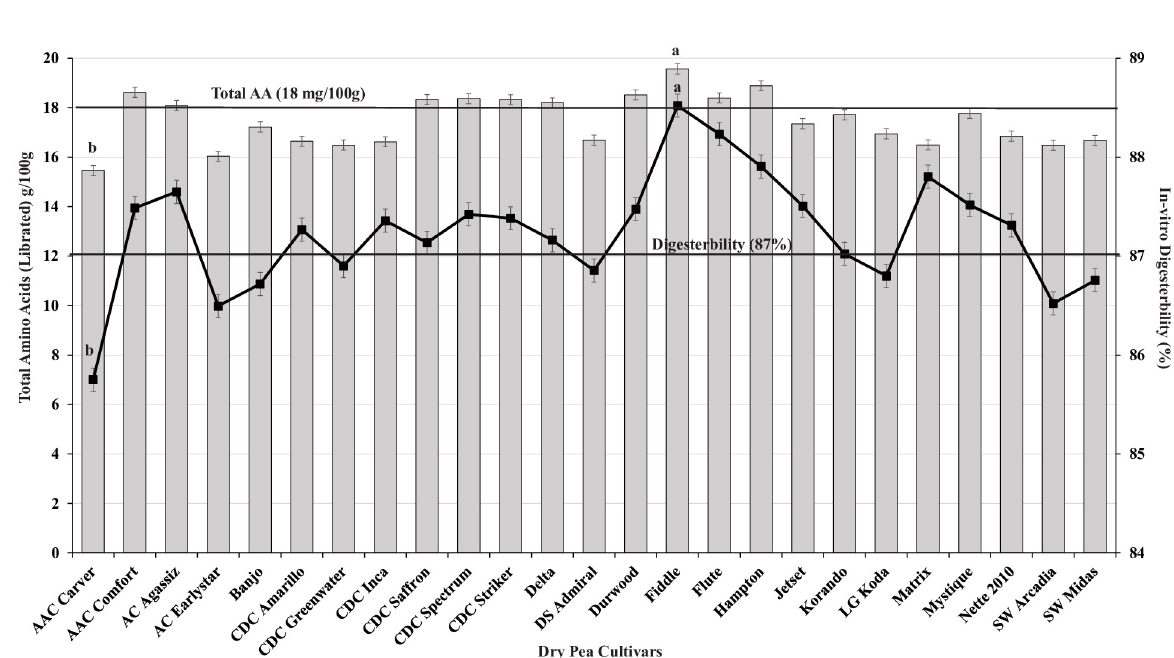
Fig 3. Total amino acids (liberated, g/100 g) and in vitro protein digestibility (%) of dry pea cultivars grown in the organic system. The bars indicate the total amino acids (liberated) g/100g and the line indicates in-vitro digesterbility (%). The bars/lines with different letters indicate significant difference at P < 0 . 05